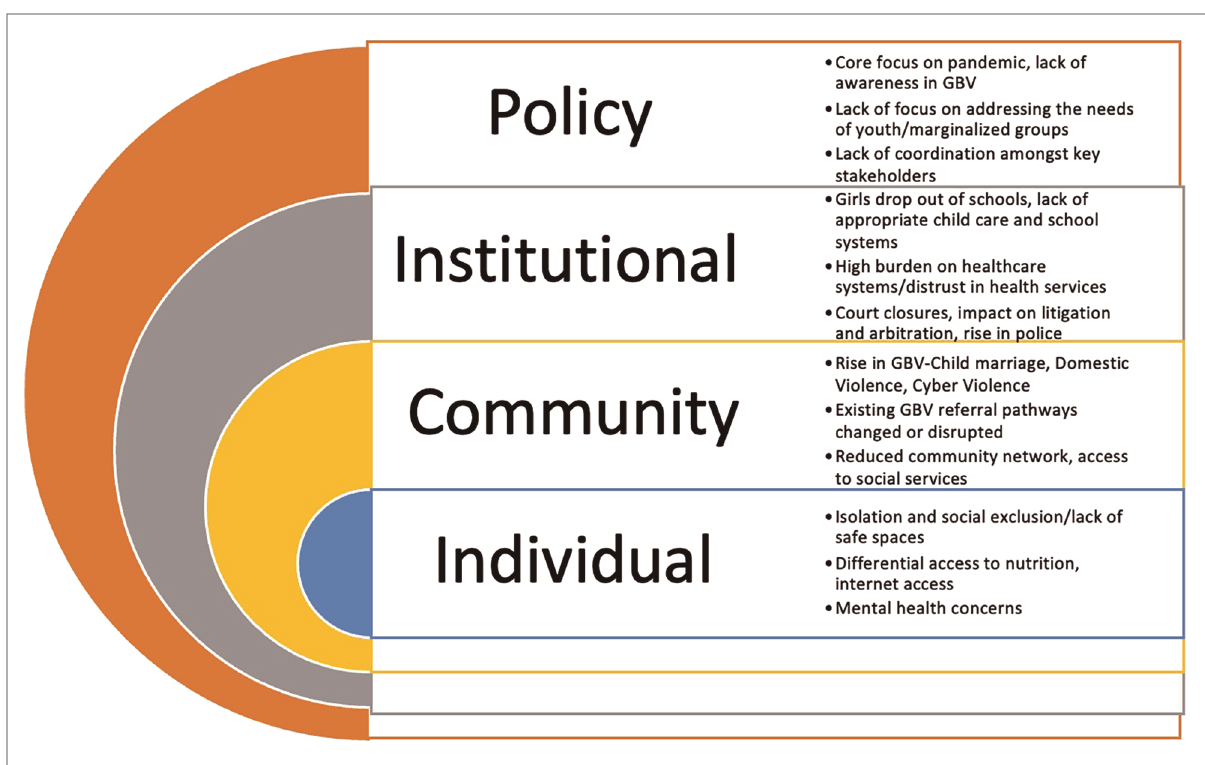
FIGURE 1 Key chellenges faced by civil society organisations while dispensing GBV services during the pandemic. This model is based on the Social Ecological Model (SEM) and is adapted in the context of GBV programming during the COVID-19